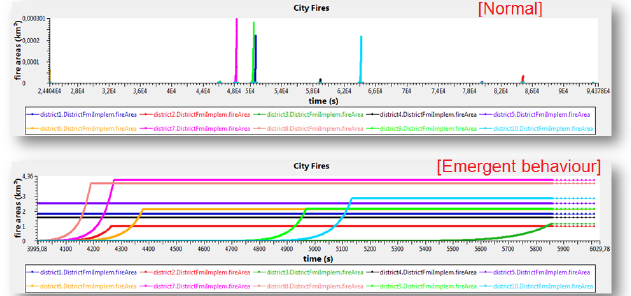
Figure 11. Simulation results in